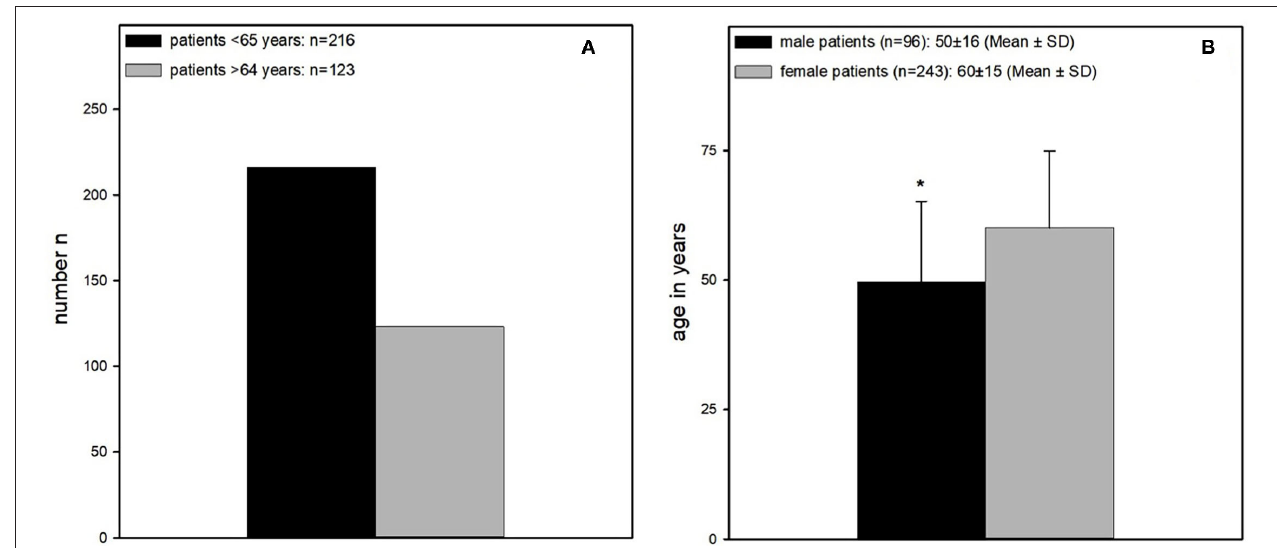
FIGURE 4 | Classification of the fractures according to the AO classification. Fractures were classified as follows: type A fractures n = 110, type B fractures n = 31, and type C fractures n = 198.